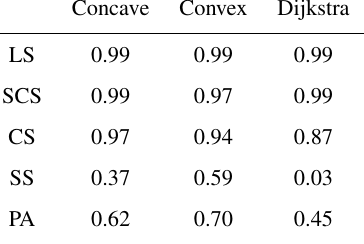
Table 3. Scenario 2 - Final Results